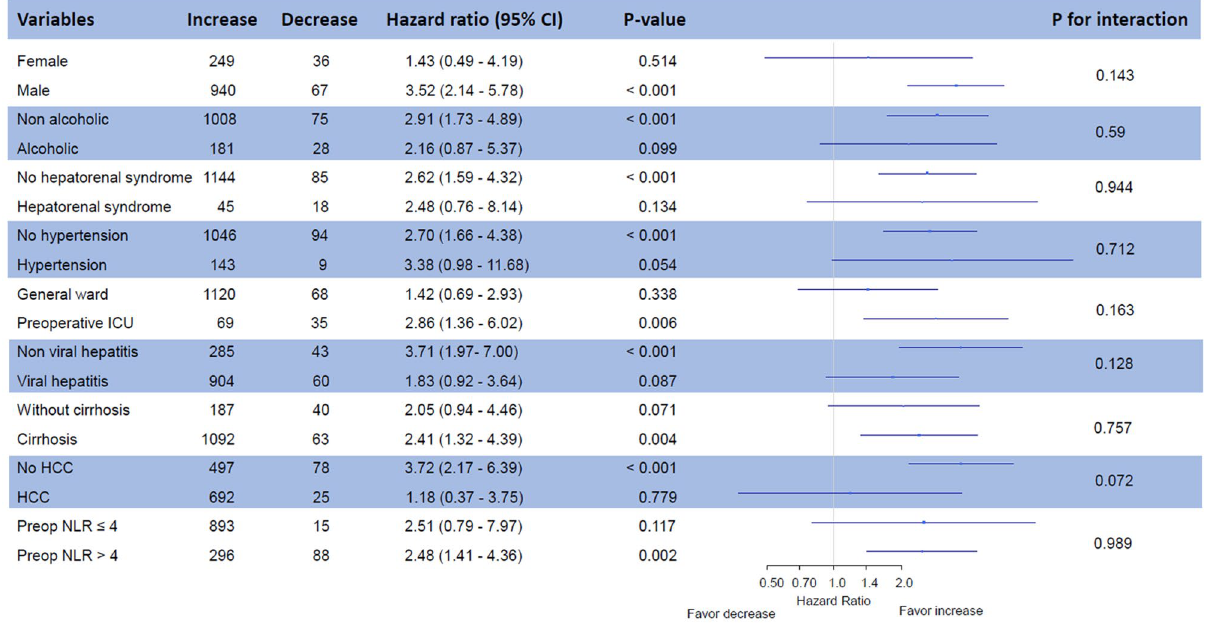
Figure 3. Forest plot for the subgroup analysis. One-year graft failure/total